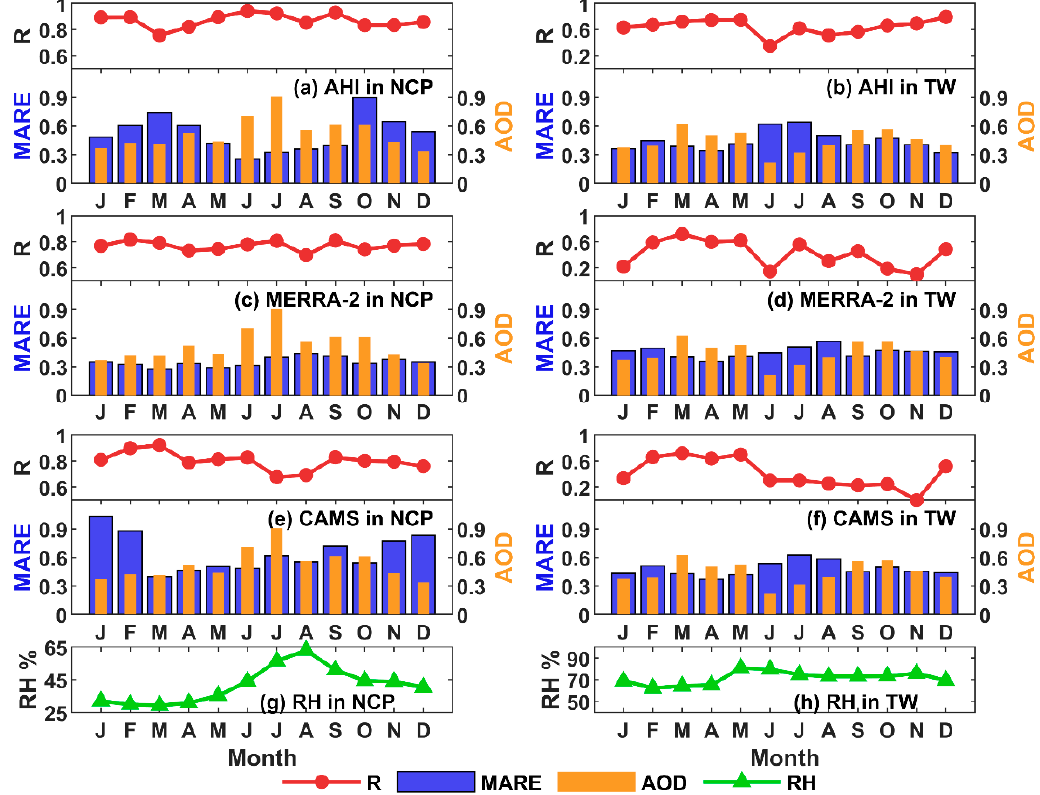
Figure 8. The seasonal cycle of R (red lines) and MARE (blue bars) between ( a – b ) AHI, ( c – d ) MERRA-2, and ( e – f ) CAMS AODs versus ground-based observations in the NCP and TW regions. Monthly AOD (orange bars) are averaged based on AERONET AOD 500 nm. Green line represents the monthly relative humidity (RH) levels near the surface.